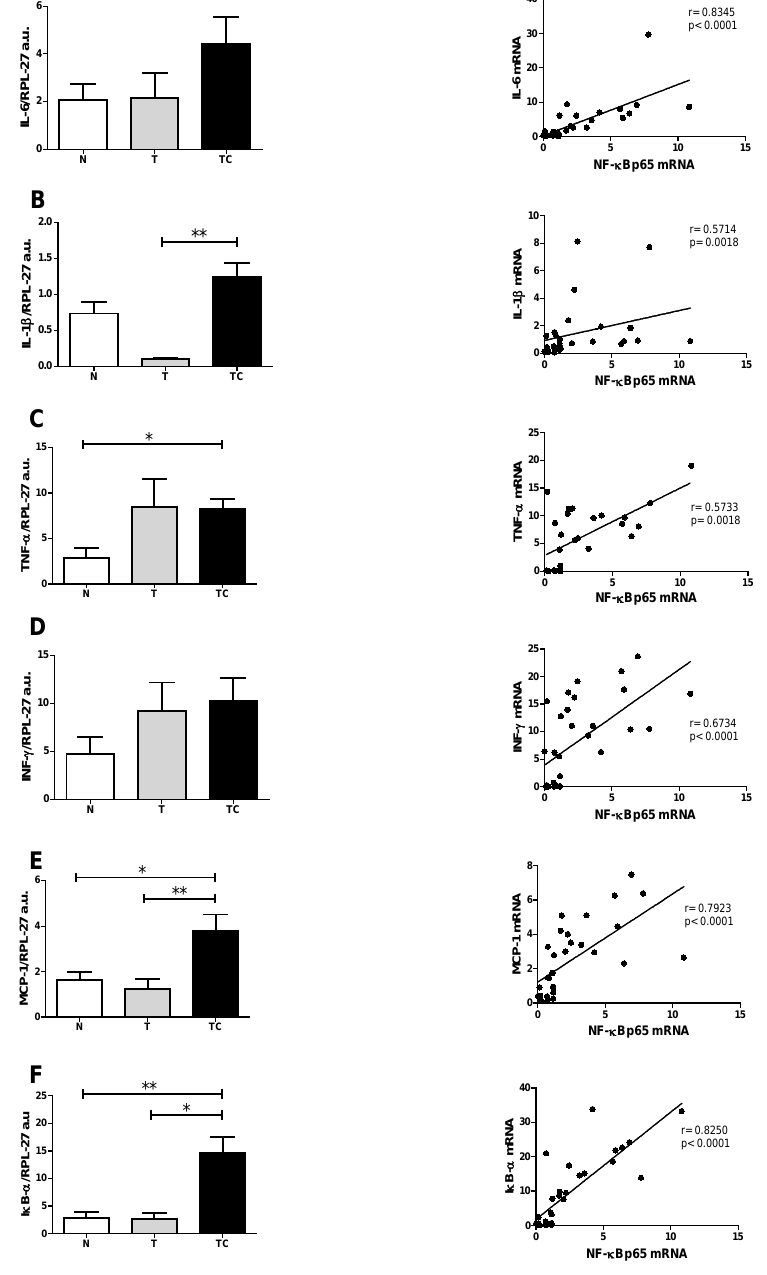
Figure 4. Subcutaneous adipose tissue gene expression and Spearman’s correlation with NF- κBp65. ( A ) IL-6; ( B ) IL1-β; ( C ) TNF-α; ( D ) INF-γ; ( E ) MCP-1; ( F ) IκB-α. Data expressed as mean ± standard error. *: p < 0.05; **: p <